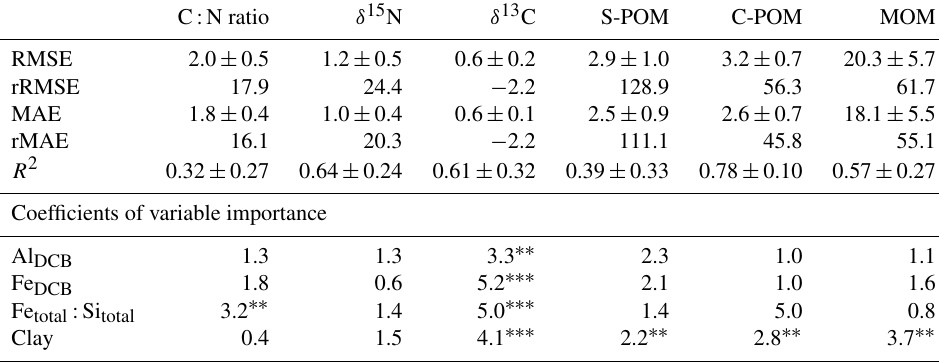
Table 3. Overview of the linear regression models describing SOM composition (C:N ratio, δ 15 N, and δ 13 C), as well as peak areas of functional groups related to simple plant-derived OM (S-POM), complex plant-derived OM (C-POM) and mainly microbial-derived OM (MOM) based on n = 30 observations. Explanatory variables related to the mineral matrix and soil texture were selected (Al DCB , Fe DCB , Fe total :Si total ratio, clay content). Absolute and relative model fit parameters (root mean squared error (RMSE and rRMSE), mean absolute error (MAE and rMAE), and R 2 ) with standard deviations were computed following 100 iterations of a Monte Carlo cross-validation. Higher coefficients of variable importance indicate a higher importance of the variable to explain the impact on the regression slope. The significance levels of each model parameter on the linear model are denoted as ∗∗∗ p< 0 . 001 and ∗∗ p< 0 .